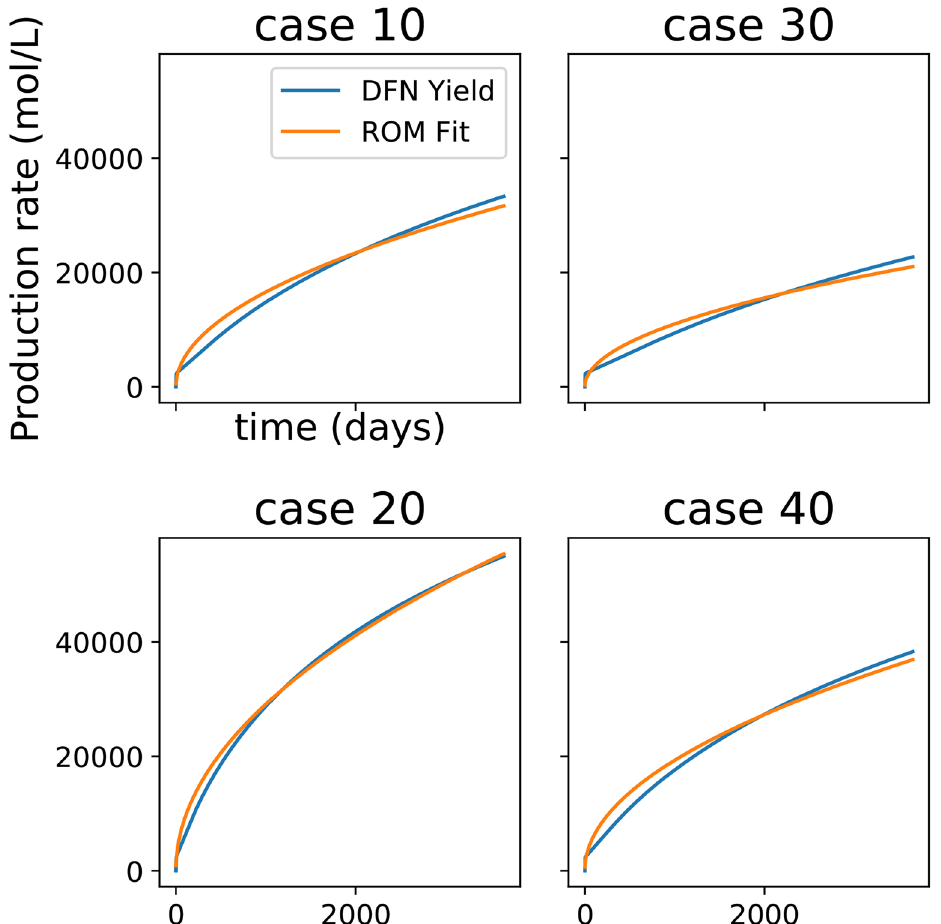
Figure 5. The Patzek reduced-order model can accurately fit the production data obtained from the high- fidelity model runs. This is evident from the root mean square (RMS) error of the fit, which is less than 10 − each of these